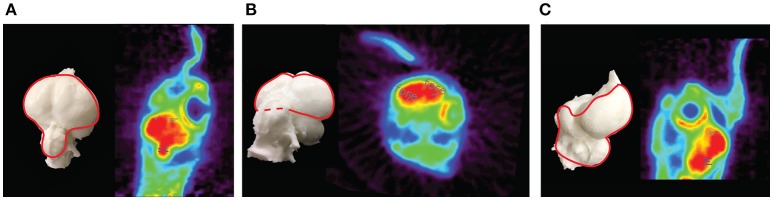
PET images of the chicken brain. Depicted are PET images and corresponding endocasts of the chicken brain. The endocast is a 3-dimensional infilling of the cranial cavity that corresponds to the shape of the brain in a living animal, rotated to be in the same orientation as each PET image. (A) A dorsal oblique horizontal slice showing the forebrain (gray dashes) and the cerebellum (blue dashes) ROIs. (B) An oblique coronal slice showing the forebrain ROI. (C) A sagittal slice showing the forebrain and cerebellum ROIs.